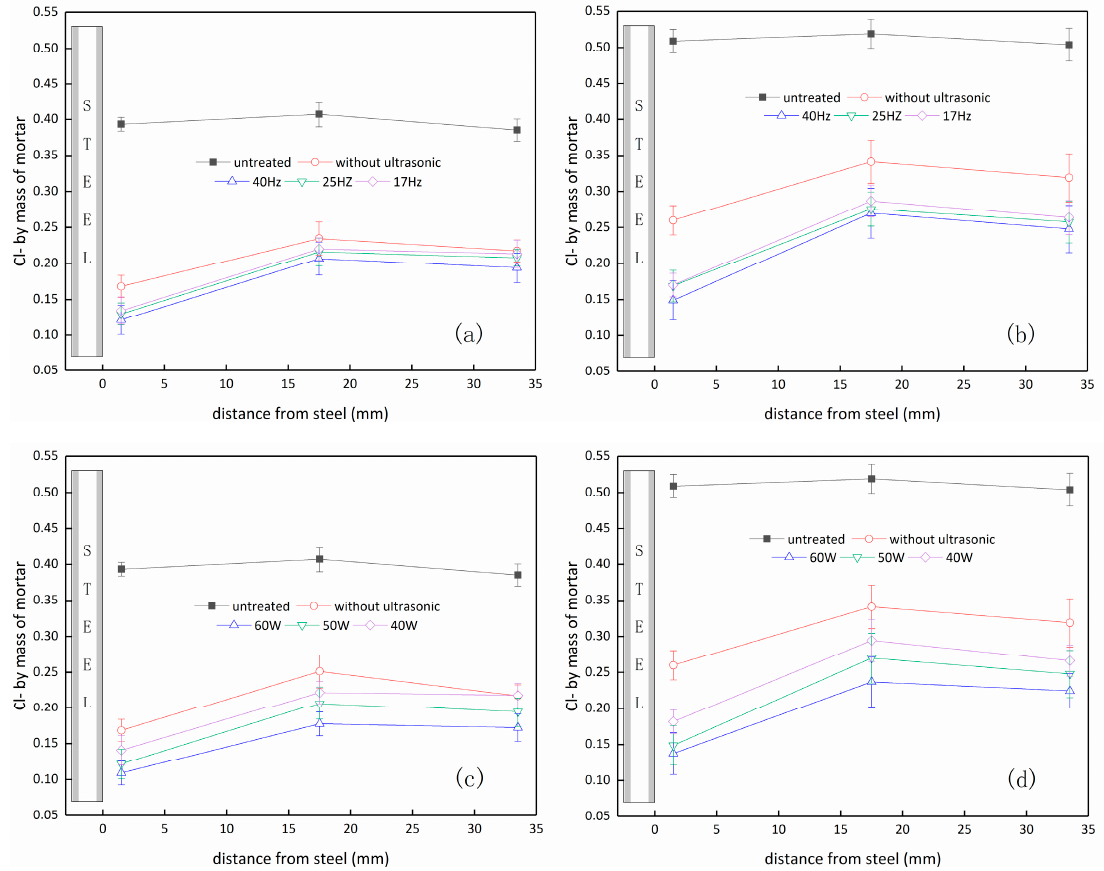
Figure 5. The distribution of chloride ion residues. ( a ) Free chloride ions at different ultrasound frequencies; ( b ) total chloride ions at different ultrasound frequencies; ( c ) free chloride ions at different ultrasound powers; ( d ) total chloride ion at different ultrasound powers.